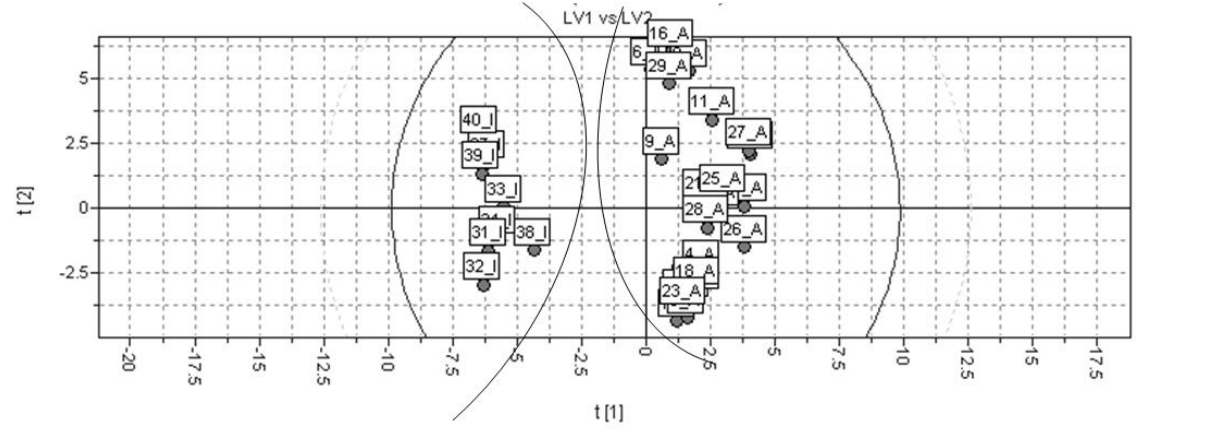
Figure 6. Discriminant PLS t1-t2 scores plot for the global model (A = active; I = inactive).